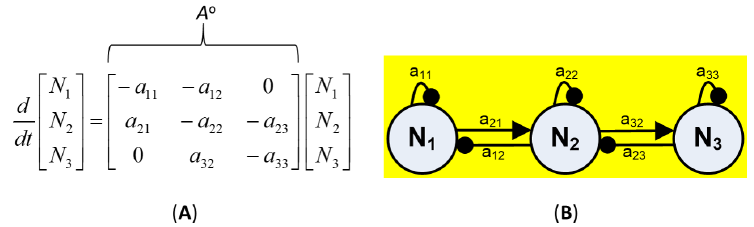
Figure 2. Example of ( A ) a 3 × 3 community matrix ( A o ) showing qualitative interaction terms for 3 variables such as species or trophic groups, with diagonal matrix elements − a 11 , − a 22 , and − a 33 representing negative self-effects of each variable and zero denoting no effect, and ( B ) its corresponding signed-digraph. Open circles denote variables ( N i ), with lines between variables ending in arrows and bubbles respectively denoting positive and negative effects, and curved lines originating and ending in the same variable denoting self-effects, after [29].